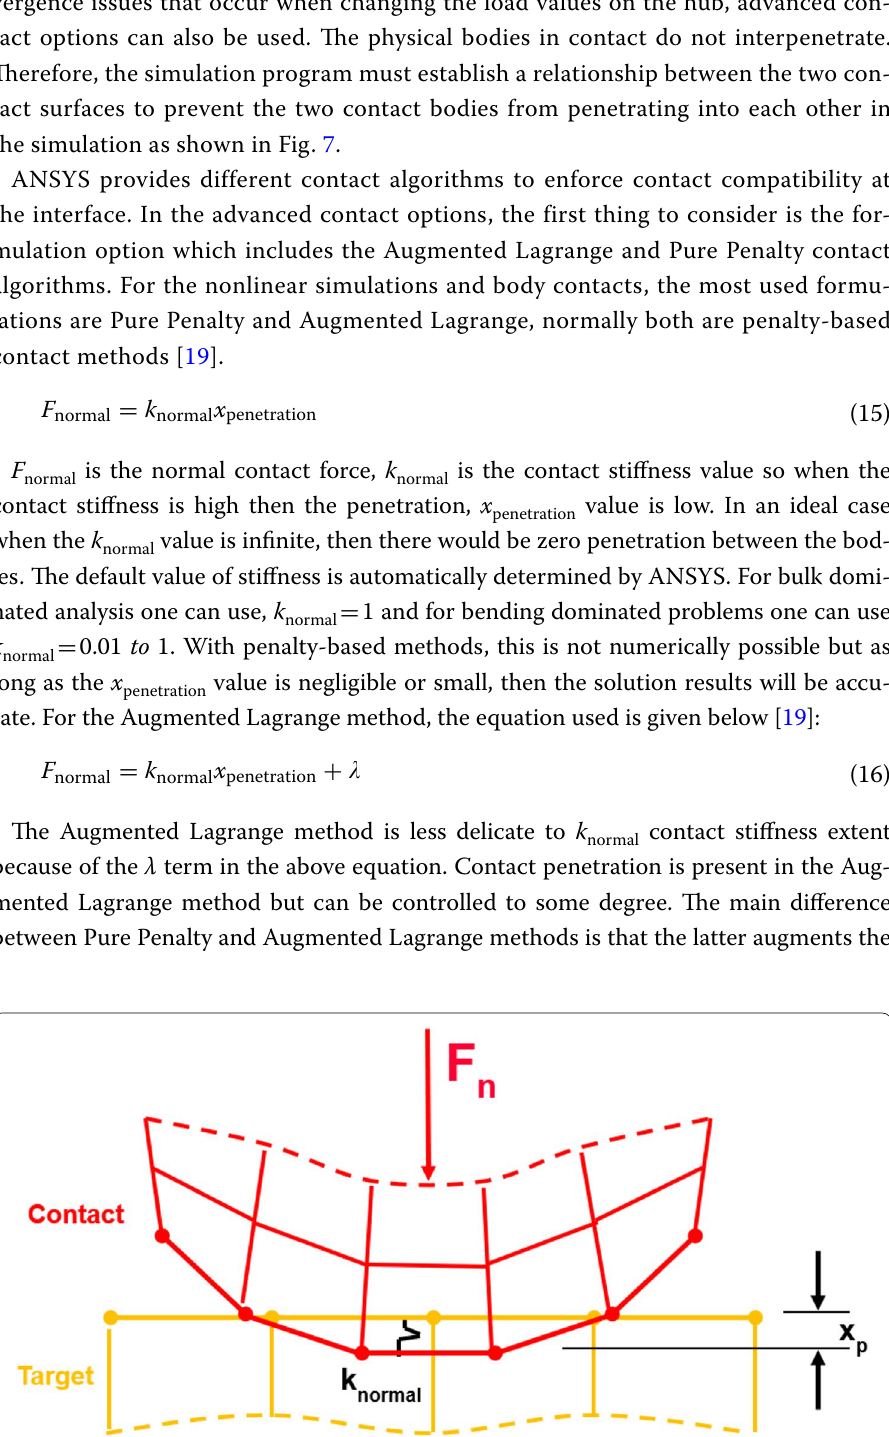
Fig. 7 Relation between normal force, contact stiffness, and contact penetration